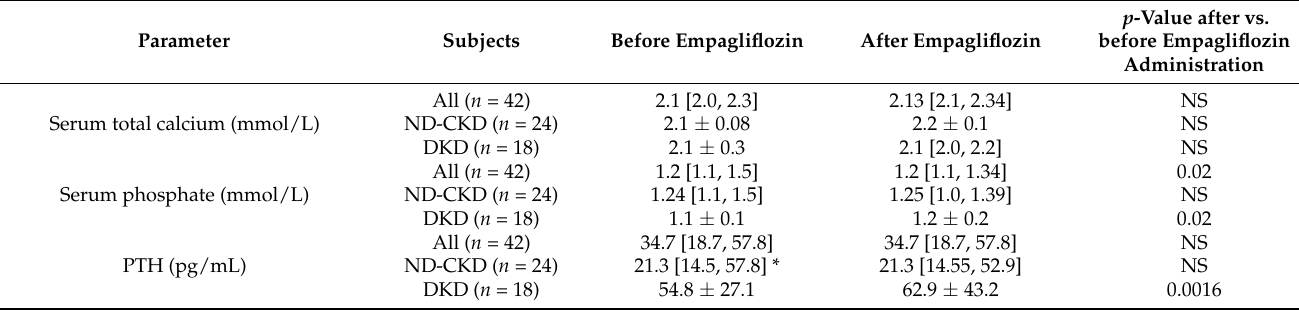
Table 2. Effect of empagliflozin on serum and urine parameters of calcium–phosphate and bone metabolism in all subjects and in subgroups of diabetic and non-diabetic patients with chronic kidney disease. Parameter Subjects Before Empagliflozin After Empagliflozin